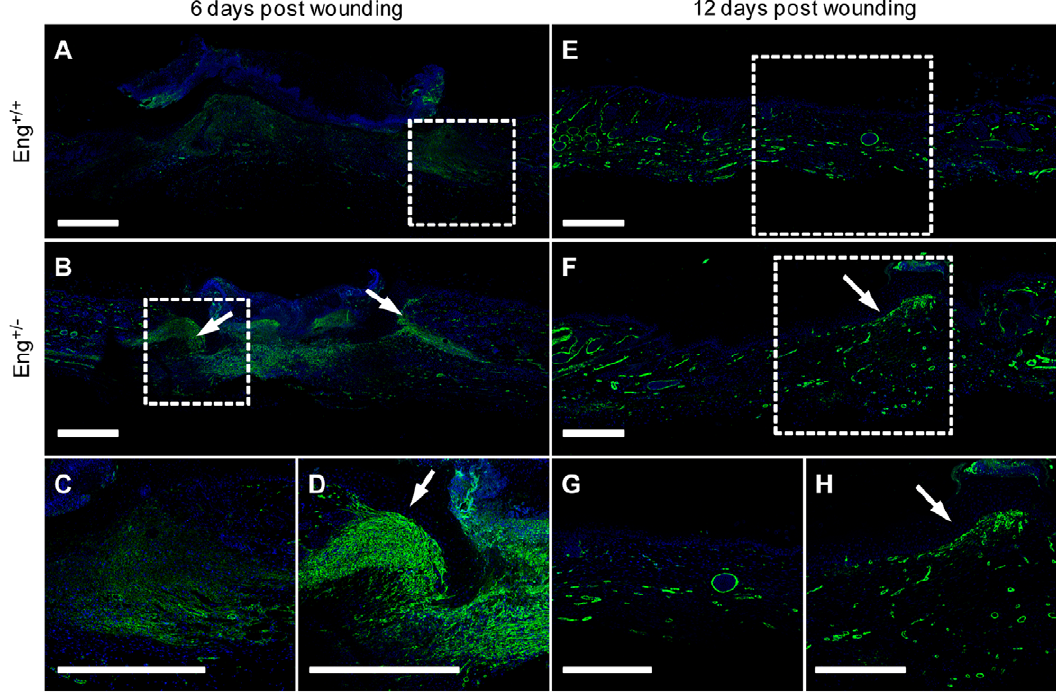
Figure 1. Histological analysis of activated fibroblasts presence during Eng + / 2 wound healing. ( A and B ) Immunofluorescence staining of alpha-smooth muscle actin ( a -SMA) on Formalin-fixed Parafin-embedded wounds from Eng + / + ( A ) and Eng + / 2 ( B ) mice at day 6. ( C and D ) Granulation tissue on wounds edges from Eng + / + ( C ) and Eng + / 2 ( D ) mice in more details. ( E and F ) Immunofluorescence staining of a -SMA on Formalin-fixed Parafin-embedded scars from Eng + / + ( E ) and Eng + / 2 ( F ) mice at day 12. ( G and H ) Eng + / + ( G ) and Eng + / 2 ( H ) day-12 scars magnification. Bars=500 mm. Arrow=Activated fibroblasts accumulation. A representative image from four independent experiments is shown. doi:10.1371/journal.pone.0054687.g001 PLOS ONE |